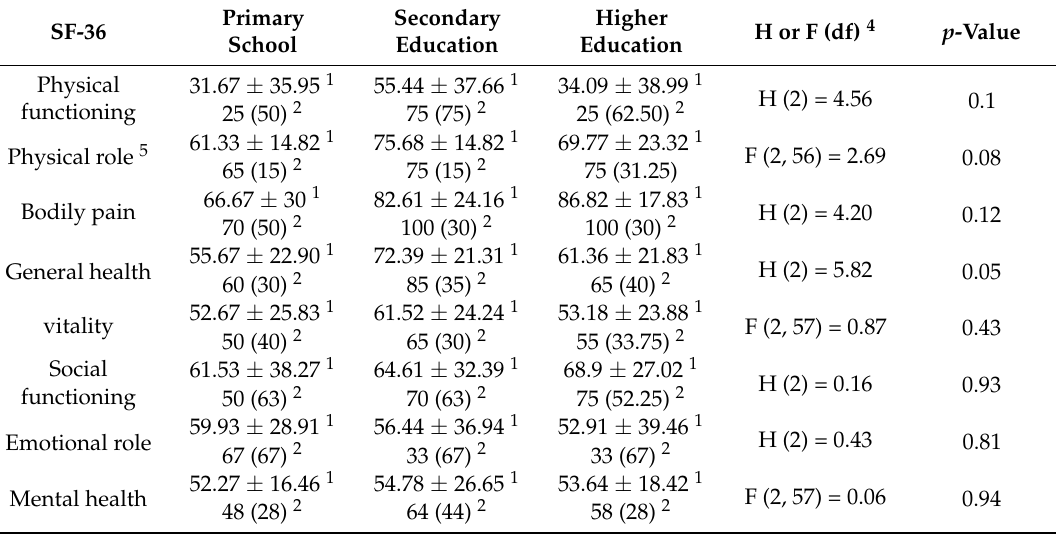
Table 6. Significant effects of education on SF-36